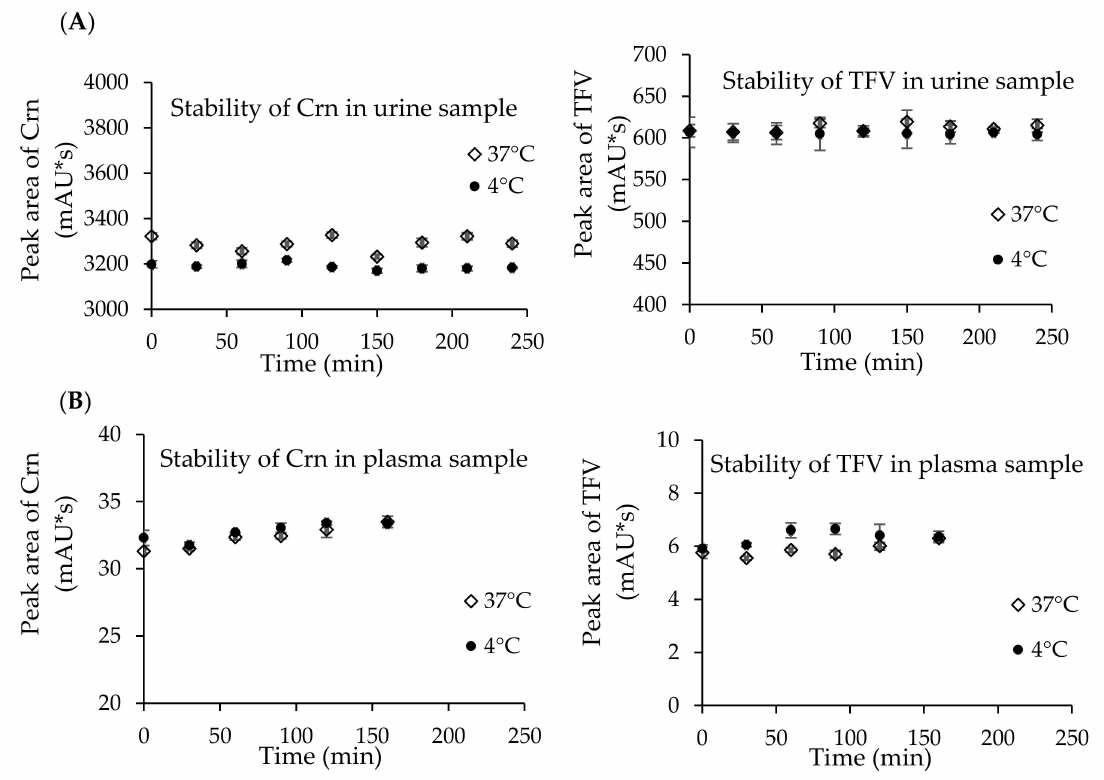
Figure 3. Stability of Crn and TFV in urine ( A ) and plasma ( B ) samples kept at 4 ◦ C and 37 ◦ C; n = 3 for each time point.